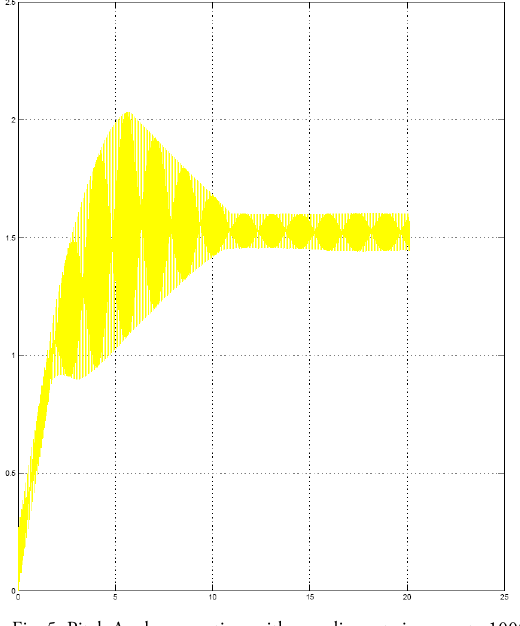
Fig. 5. Pitch Angle versus time with sampling rate increase to 1000 sample/sec.